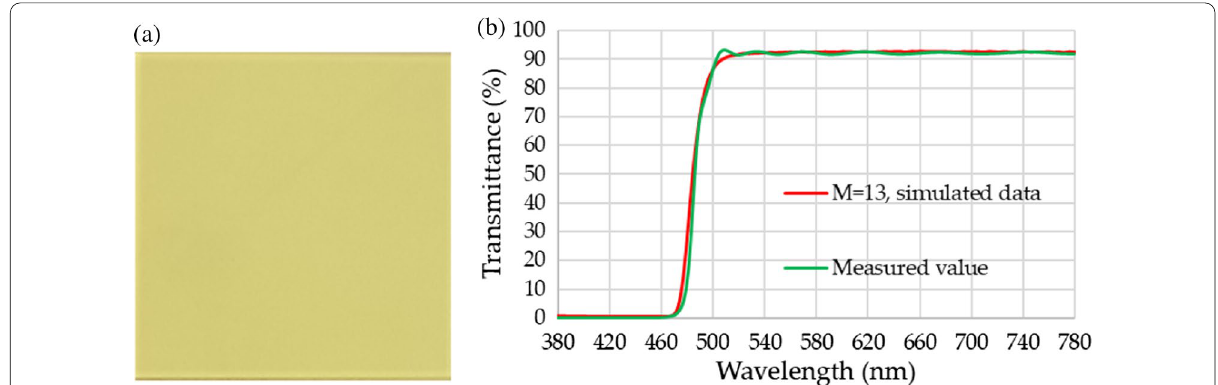
Fig. 8 RCPEF sample: a prototype sample, b measured value of penetration rate of